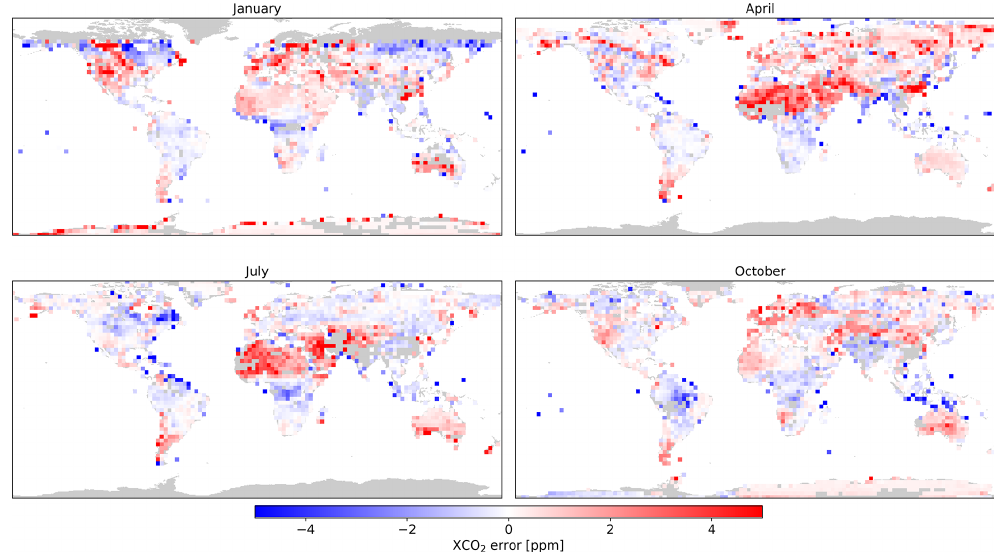
Figure 3. Similar to Fig. 3 but for OCO-2 synthetic spectra.